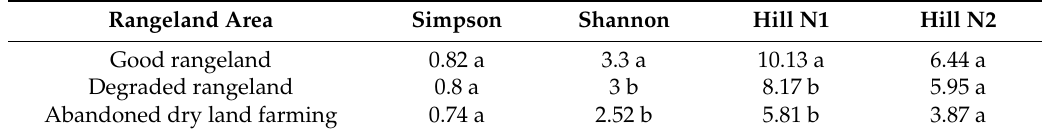
Table 5. Mean values of plant diversity indices in the study rangeland area based on the canopy cover of all species